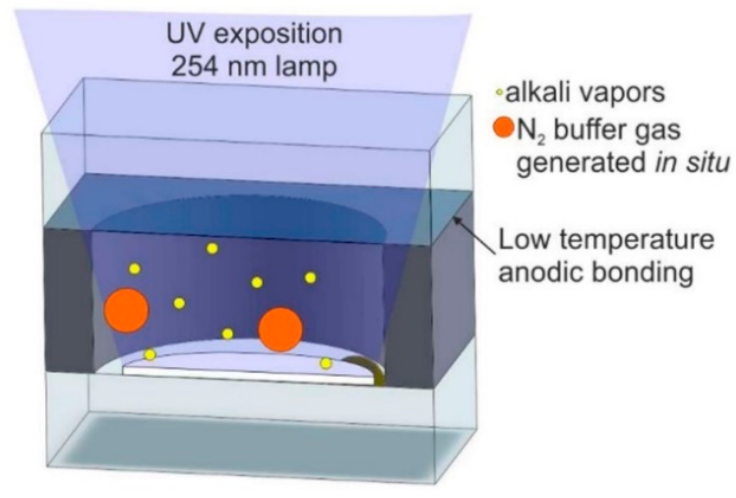
Figure 15. Process flow diagram for preparing atomic vapor cells using photodegradable CsN 3 films. Reprinted from Ref [56].